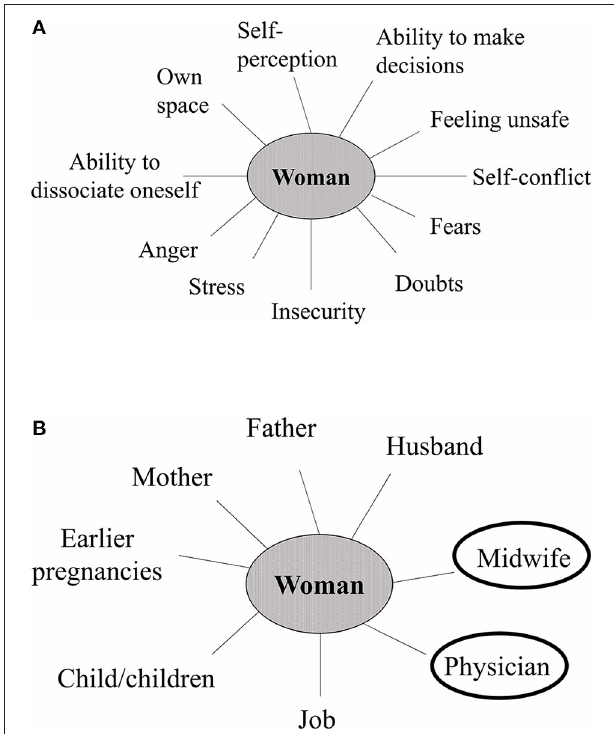
FIGURE 1 | The psychological well-being of a woman during pregnancy depends on the combination of her internal emotions and external relationships. (A) Internal emotions. A pregnant woman experiences a wide range of internal emotions which are partly influenced by her own childhood experiences and partly by the physiological changes of pregnancy. (B) External relationships. Resilience and stress both can originate from a woman’s social relationships. Social support from family, friends as well as healthcare providers is particularly important to promote maternal mental